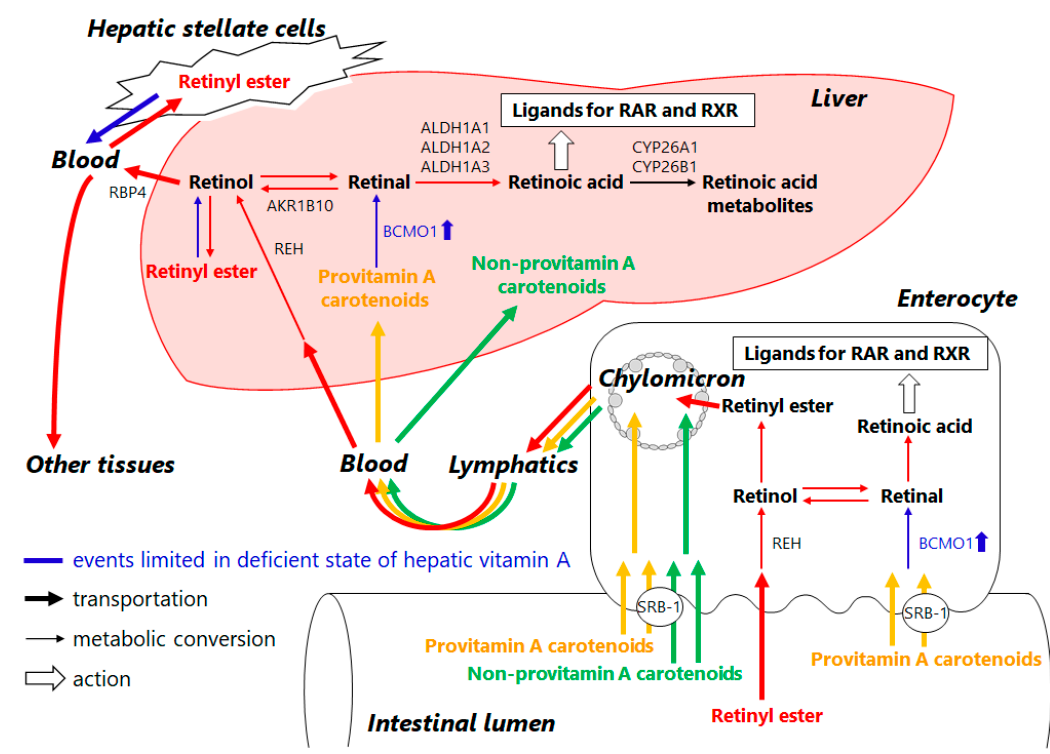
Figure 4. Transportation and metabolism of retinoids in the normal and vitamin A deficient states of the small intestine and liver: Retinyl ester is usually provided by the daily diet and transported via chylomicrons into the liver. In the normal state of the liver, retinoids are sufficient and stored as retinyl ester mainly in the hepatic stellate cells, while, in the vitamin A deficient state of the liver (shown by blue color symbols and events), dietary retinoids are insufficient and retinyl ester stored in the hepatic stellate cells are consumed throughout the body. Additionally, upregulation of BCMO-1 metabolically converts provitamin A carotenoids to retinal for complement of retinoids. REH: retinyl ester hydrolase, RBP4: retinol-binding protein 4, SRB-1: scavenger receptor class B type 1, BCMO-1: β -carotene 15,15 ′ -monooxygenase 1.